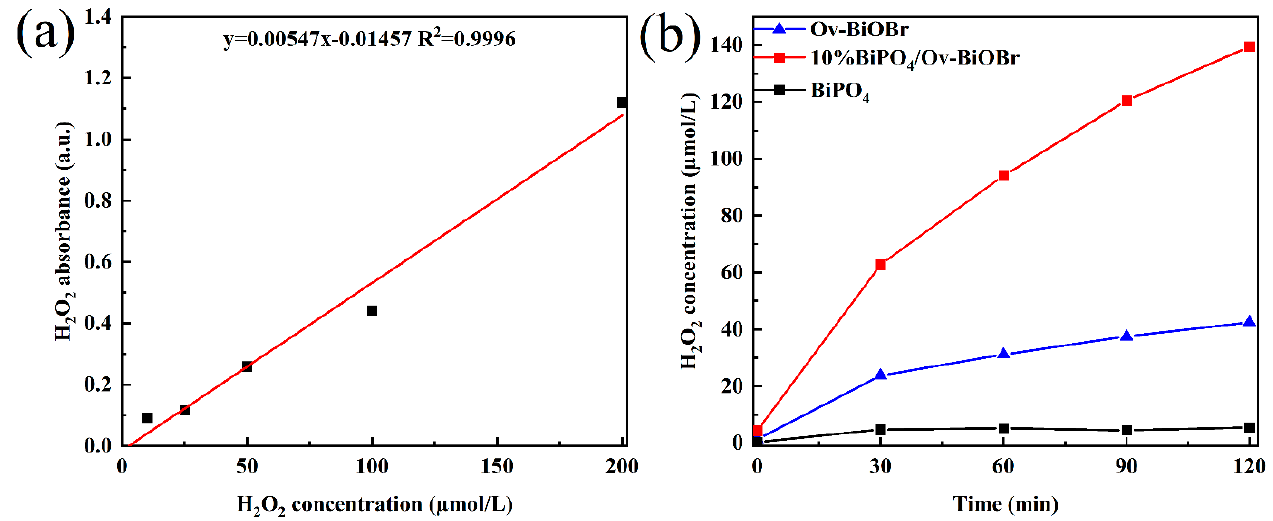
Figure 9. Concentration-absorbance curve of H 2 O 2 ( a ); time-concentration curve of H 2 O 2 produced under visible light irradiation ( b ).